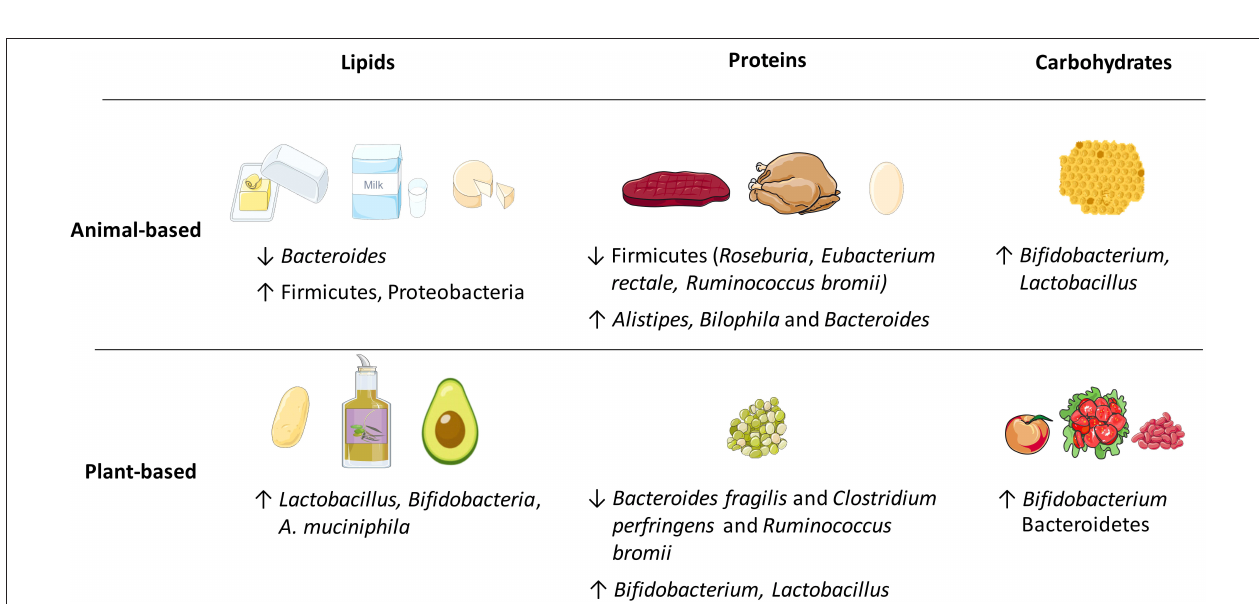
FIGURE 2 | Examples of energy-delivering macronutrients, including lipids, proteins, and carbohydrates that produce various changes in the relative abundance of gut microbiota. The animal or plant-based origin dramatically influences the outcomes.